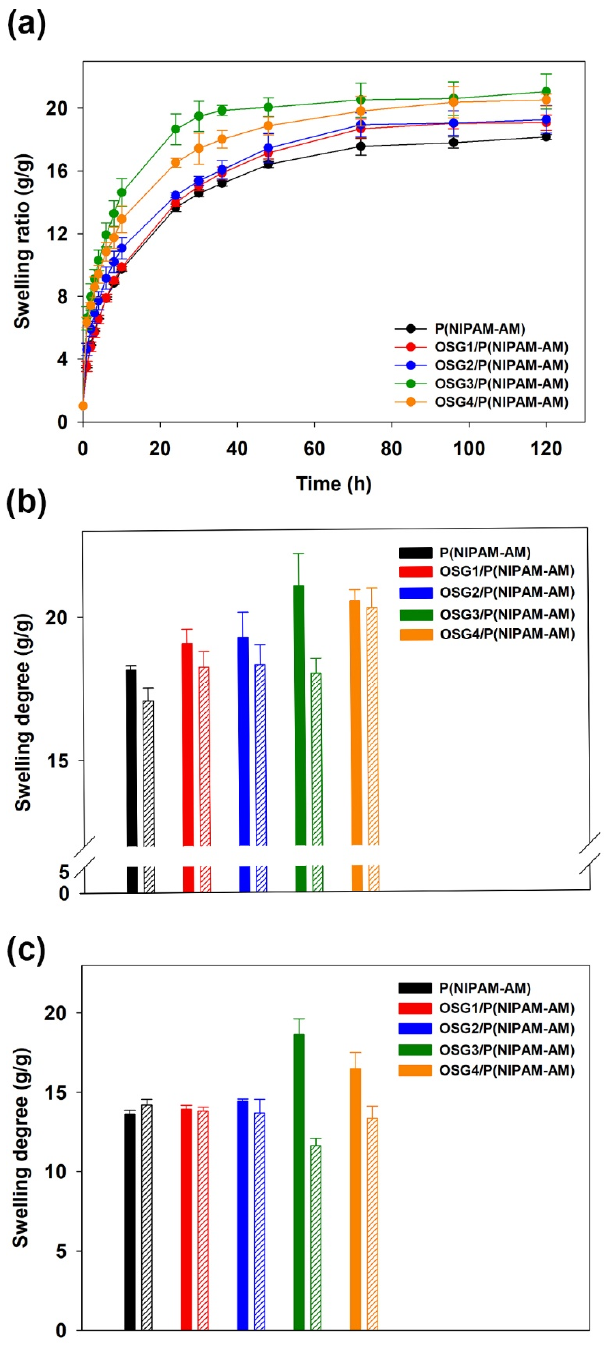
Figure 8. Equilibrium swelling ratio of hydrogels ( a ). Swelling ratio of hydrogels at different temperatures ( b ) and different pH ( c ).